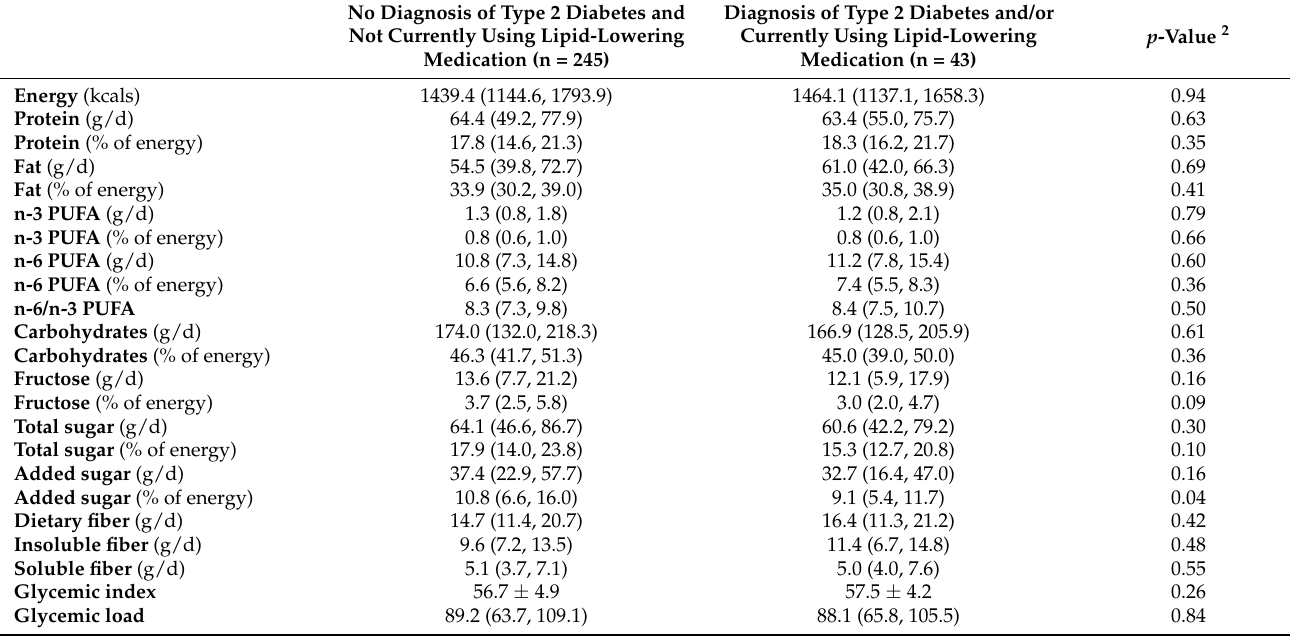
Table A2. Comparison of Self-Reported Repeat 24-h Recall Dietary Intake Among Participants Who Self-Reported a Type 2 Diabetes Diagnosis and/or Current Use of Lipid-Lowering Medication (n = 43) and Those Who Did Not (n = 245) 1 . No Diagnosis of Type 2 Diabetes and Not Currently Using